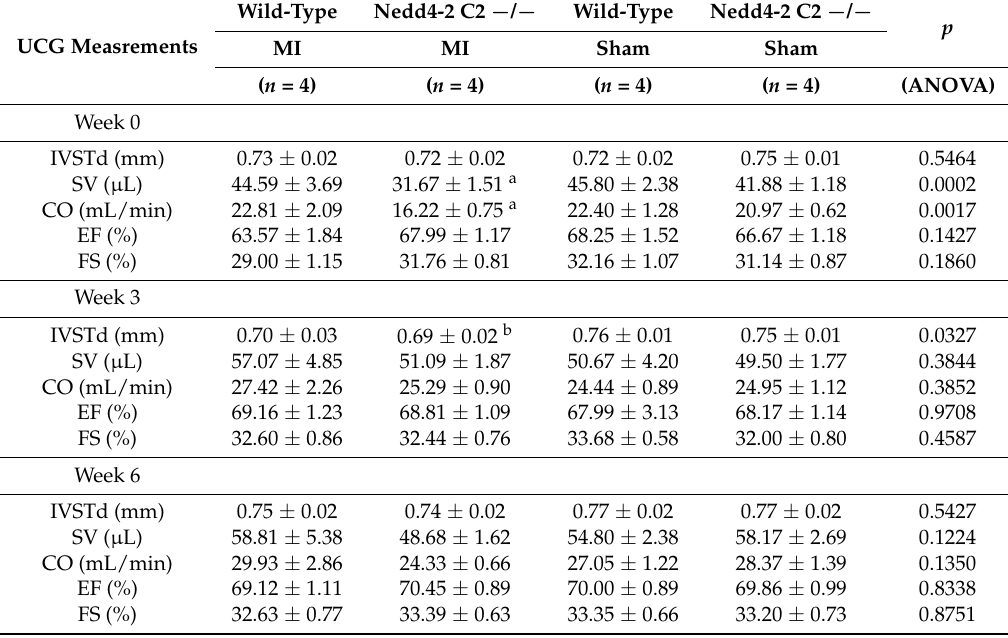
Table 3. Comparison of echocardiographic findings between wild-type and Nedd4-2 C2-knockout mice after myocardial infarction. Male wild-type littermates ( n = 4; 11–14 weeks old) and Nedd4-2 C2 − / − mice ( n = 4; 11–14 weeks old) were used for this experiment. Data are expressed as means ± SE. MI, myocardial infarction; IVSTd, intraventricular septal thickness in diastole; SV, stroke volume; CO, cardiac output; EF, ejection fraction; FS, fractional shortening; ANOVA, two-way analysis of variance. a p < 0.05 vs. wild-type MI, wild-type sham, Nedd4-2 C2-knockout sham; b p < 0.05 vs. wild-type sham, Nedd4-2 C2-knockout